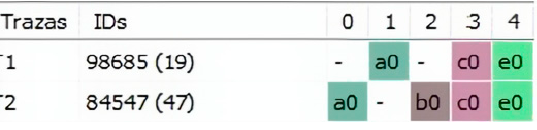
Figure 13. Sequences with check cancellations without prior suppression of products.